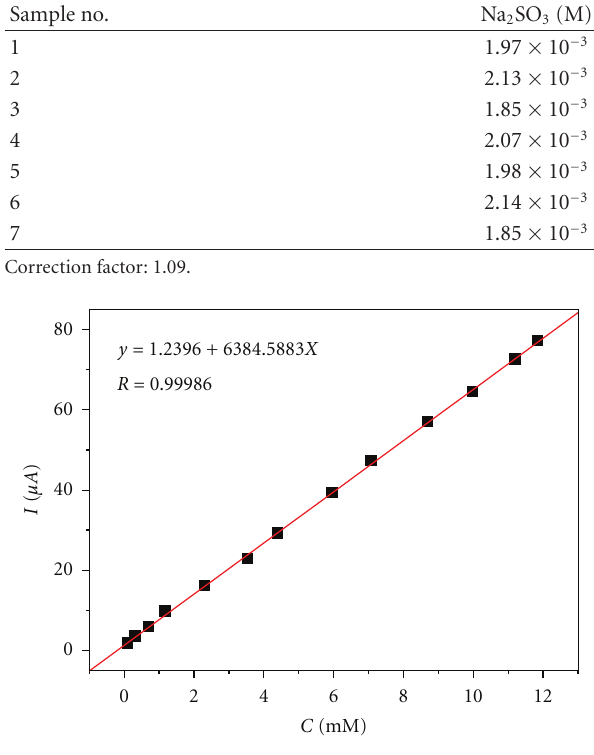
Figure 4: Calibration curve of sulfur determined by di ff erential pulse voltammetry using standard